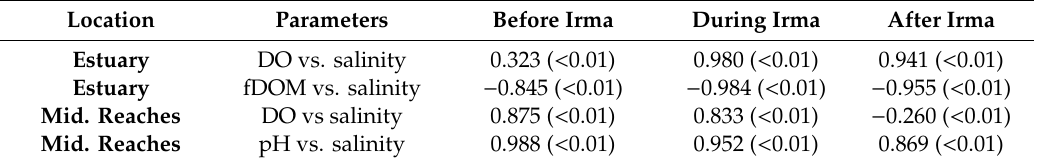
Table 1. Correlations compared before, during, and after Hurricane Irma as well as overall for the chosen parameters. p values in